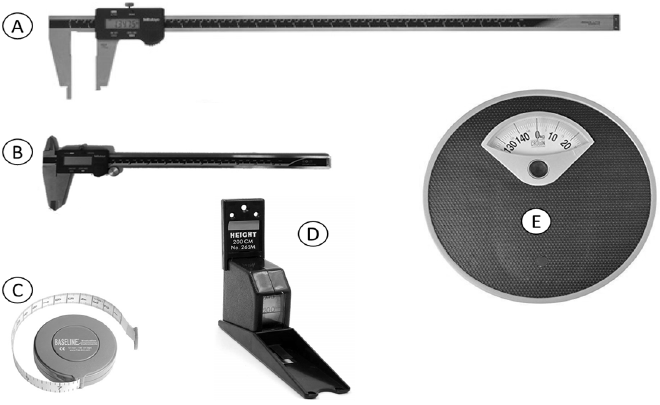
Figure 2. Measuring instruments used in the survey. Note: ( A ) larger sliding caliper; ( B ) small sliding caliper; ( C ) plastic measuring tape; ( D ) stadiometer and ( E ) weighing scale.